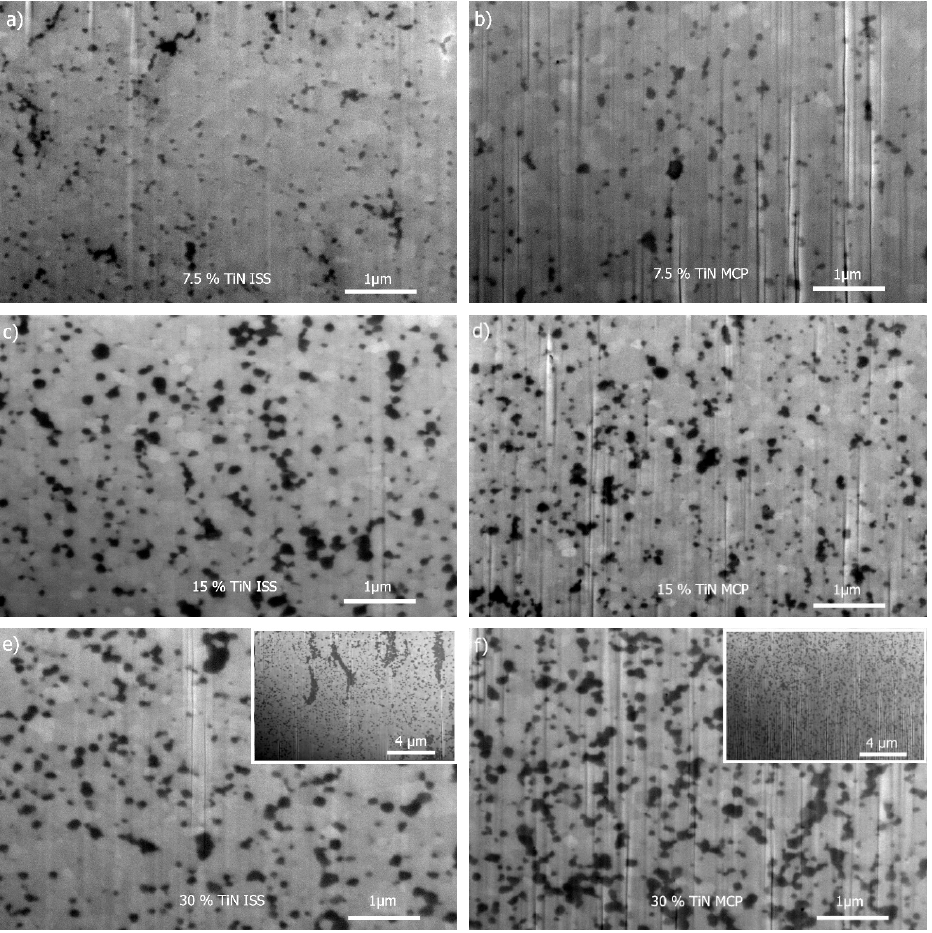
Figure 3. Back-scattered SEM micrographs of SP-sintered samples for various powder compositions